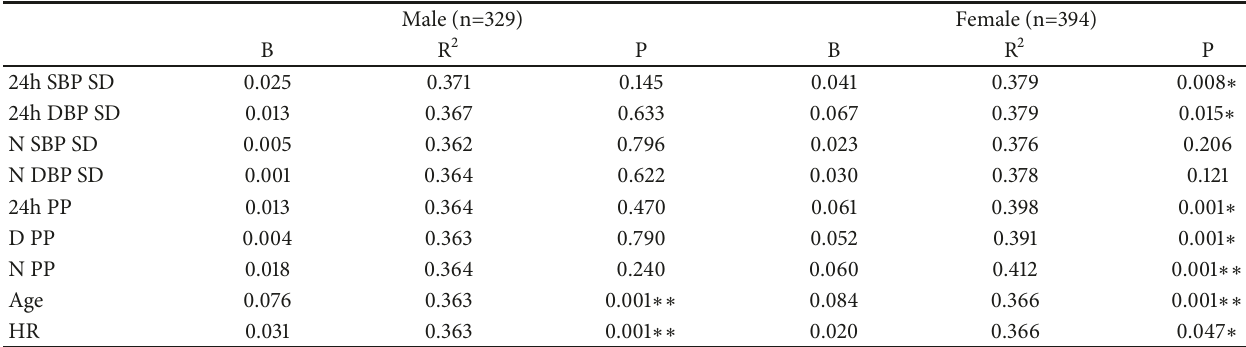
Table 6: Association of CF-PWV with BPVs and PP in male and females, by multivariable-adjusted linear regression analysis. Male (n=329) Female (n=394) B R 2 P B R 2 P 24h SBP SD 0.025 0.371 0.145 0.041 0.379